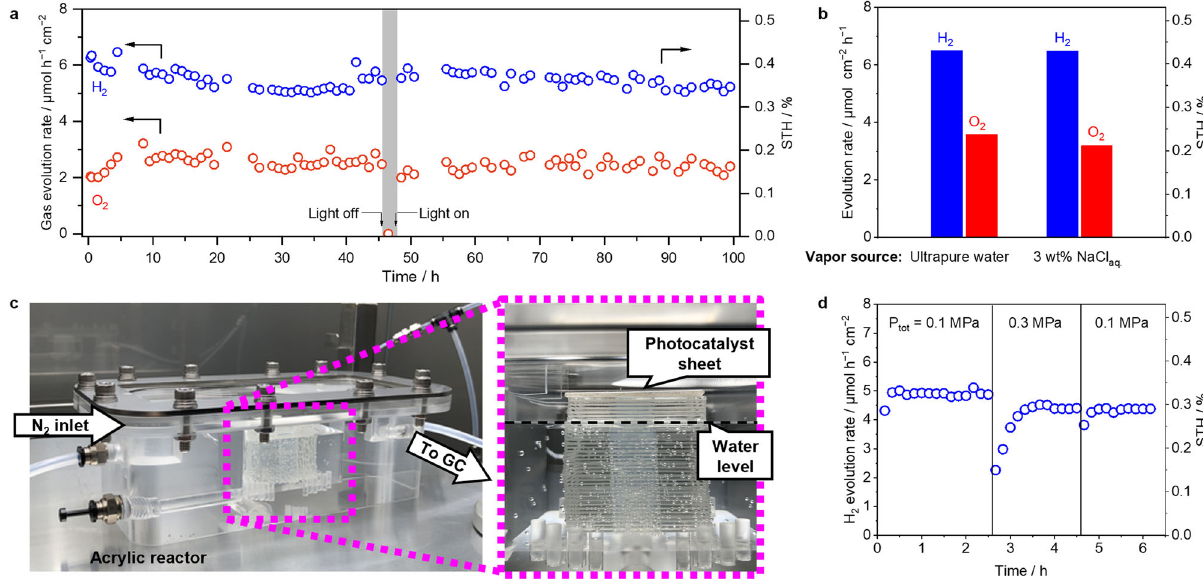
Fig.5|Practicalfeasibilitystudyofphotocatalyticoverallwatersplittingunder vapor feeding. a Durability test of CoOOH/Rh loaded SrTiO 3 :Al coated with TiO x under saturated water vapor feeding balanced with Ar at 24°C (10mLmin − 1 , p H2O =2.9kPa). The light source was a simulated sunlight (AM 1.5G). b The overall water splitting rate of CoOOH/Rh loaded SrTiO 3 :Al coated with TiO x under water vaporfeedingsupplied from ultrapurewater orbrine (3wt% NaCl aq )balancedwith